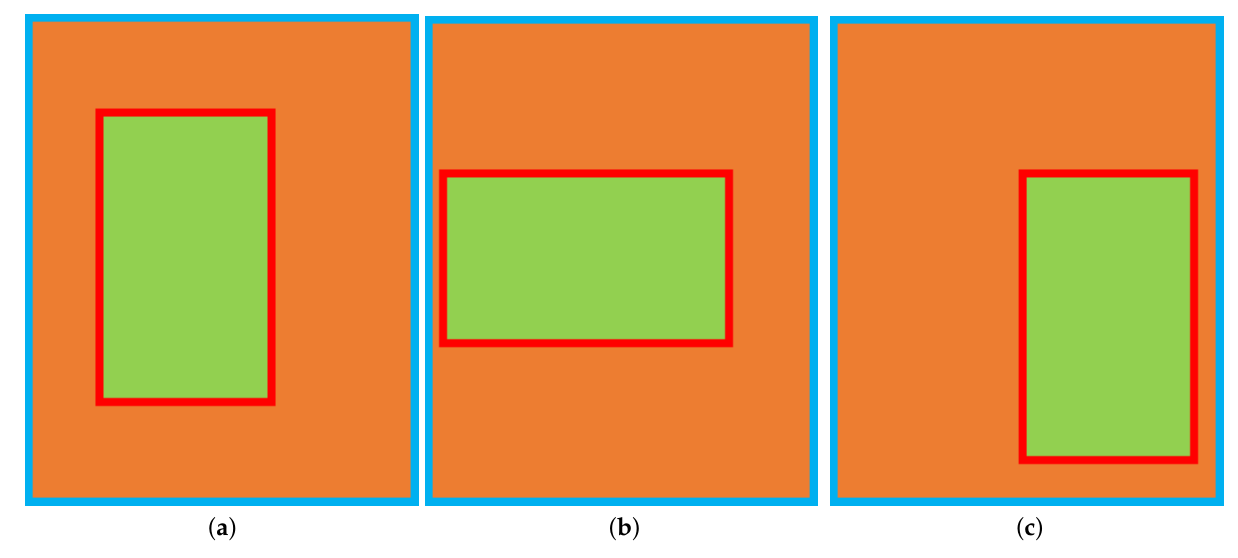
Figure 9. GIoU faces the case of a box contained in another box. ( a – c ) denote the different B contained in the same B gt inner where the area of B remains unchanged. Both B ∪ B gt (the green part) and C (the orange part) are the same, resulting in the same value for GIoU.